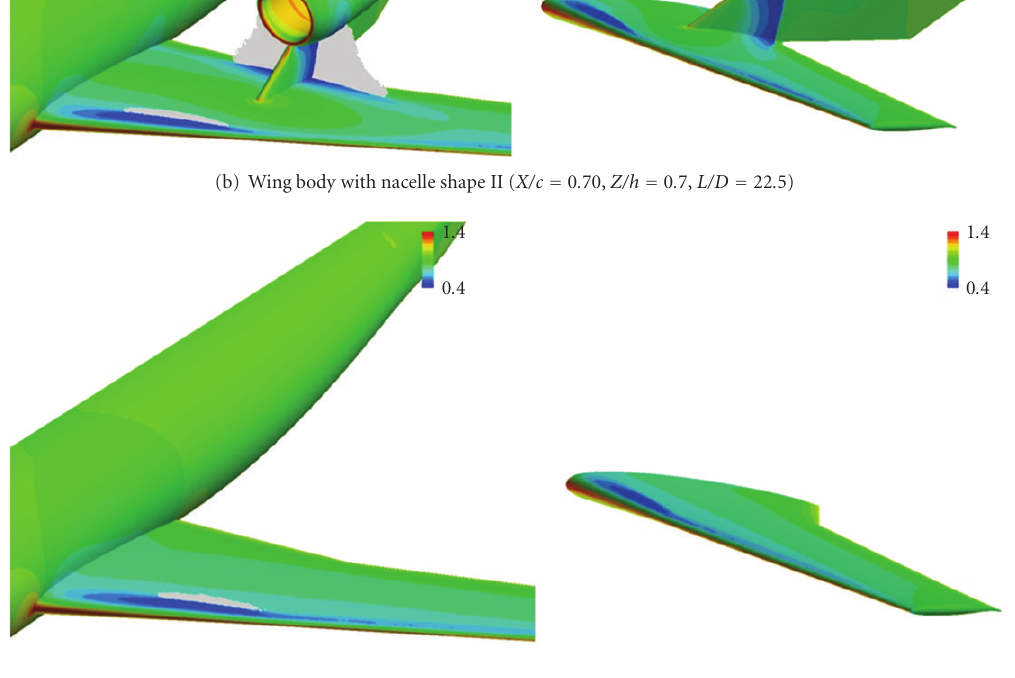
Here, GA is used to maximize the function to find the best parameter of θ as it is k -dimensional unconstrained nonlinear problem. The Kriging model is then established, and the objective function is estimated using